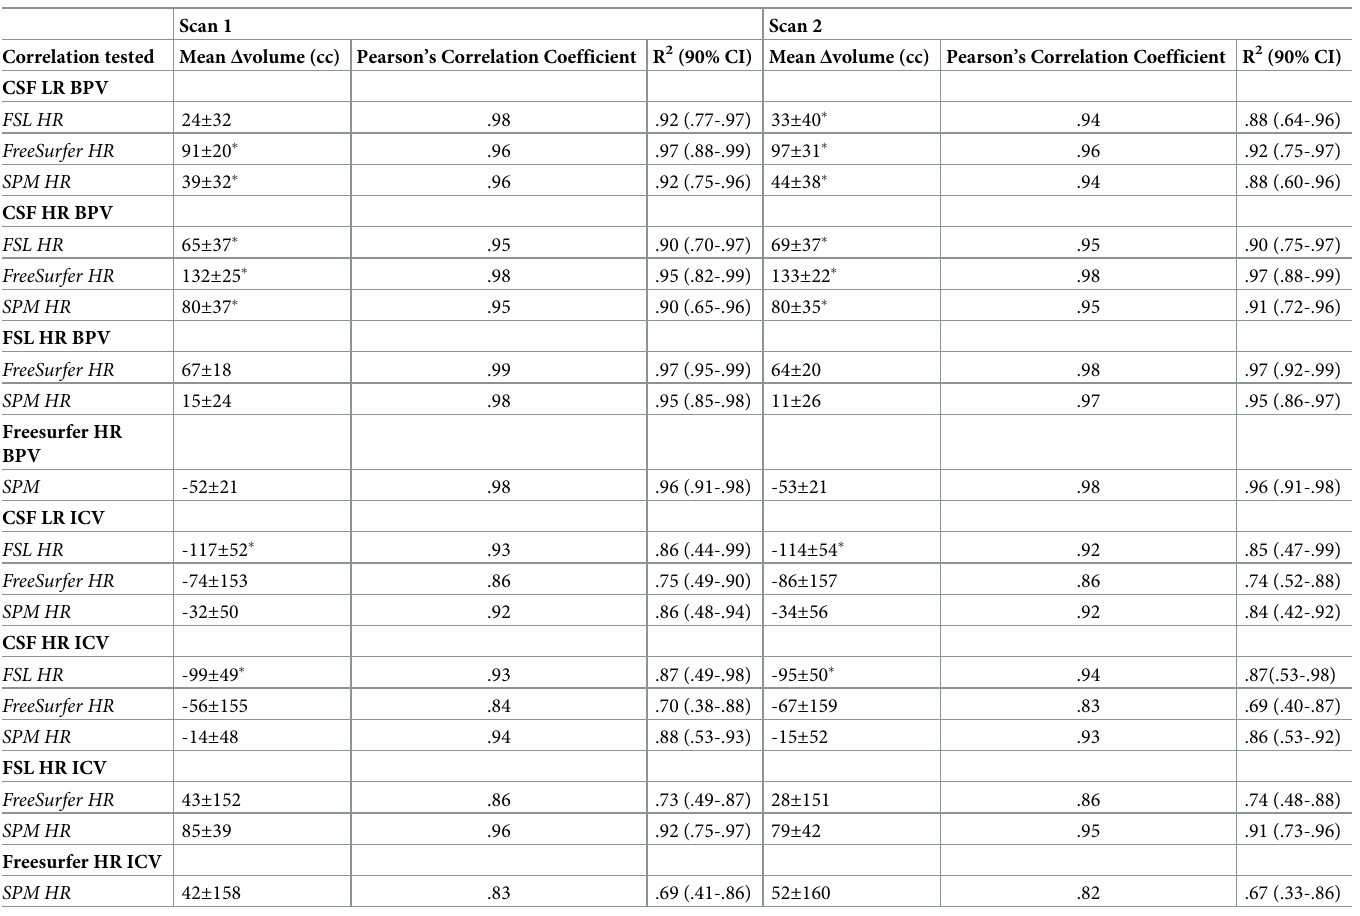
Table 2. Correlation between the CSF MRI sequences and the HR 3D T 1 -based brain segmentation methods. Scan 1 Scan